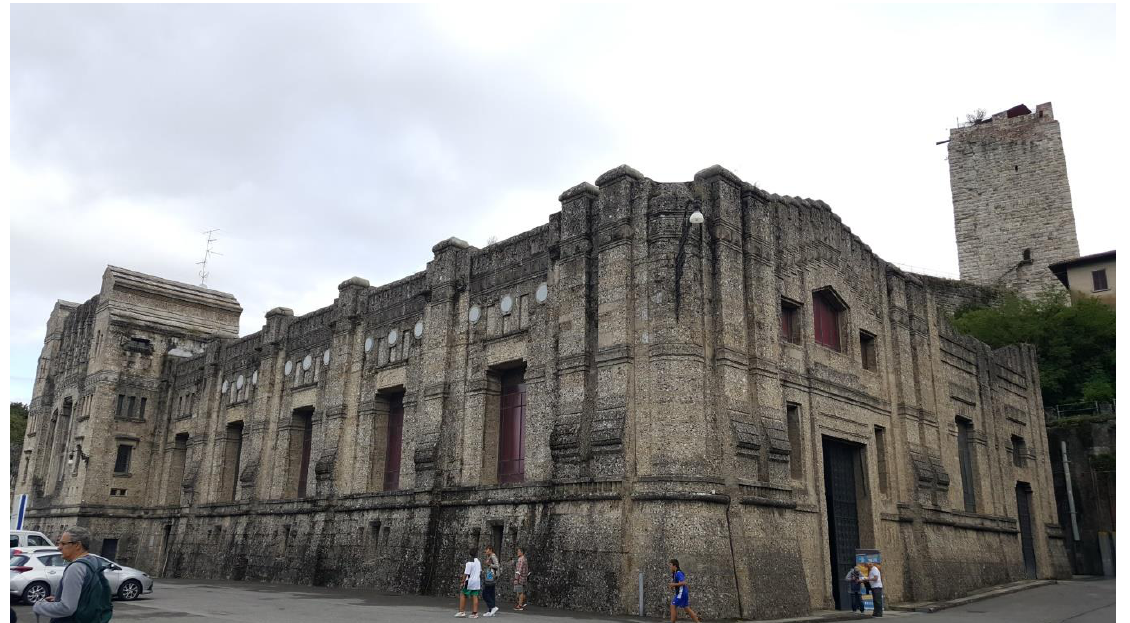
Figure 3. Taccani Hydroelectrical Power Station (built in 1906) (photo taken by the author on 9 September 2019).